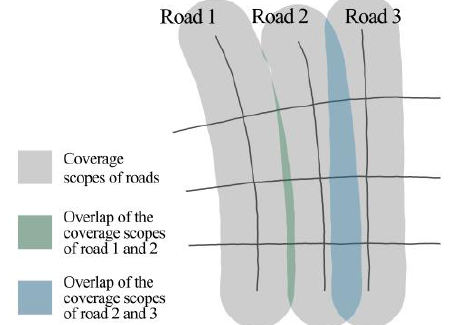
Figure 6. Coverage scopes of roads and their overlaps